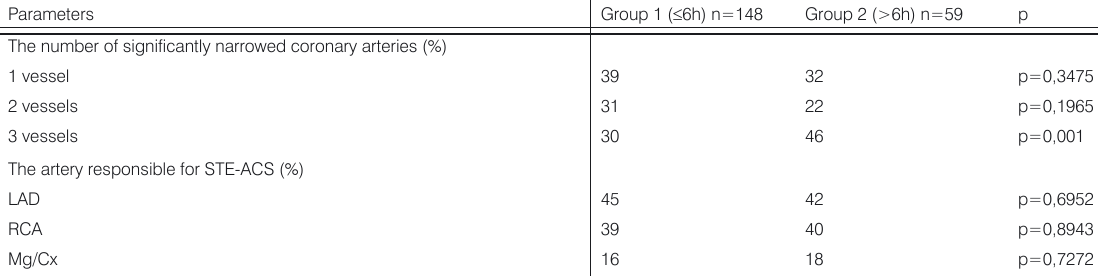
Table 3. Comparison of PCI results between Parameters